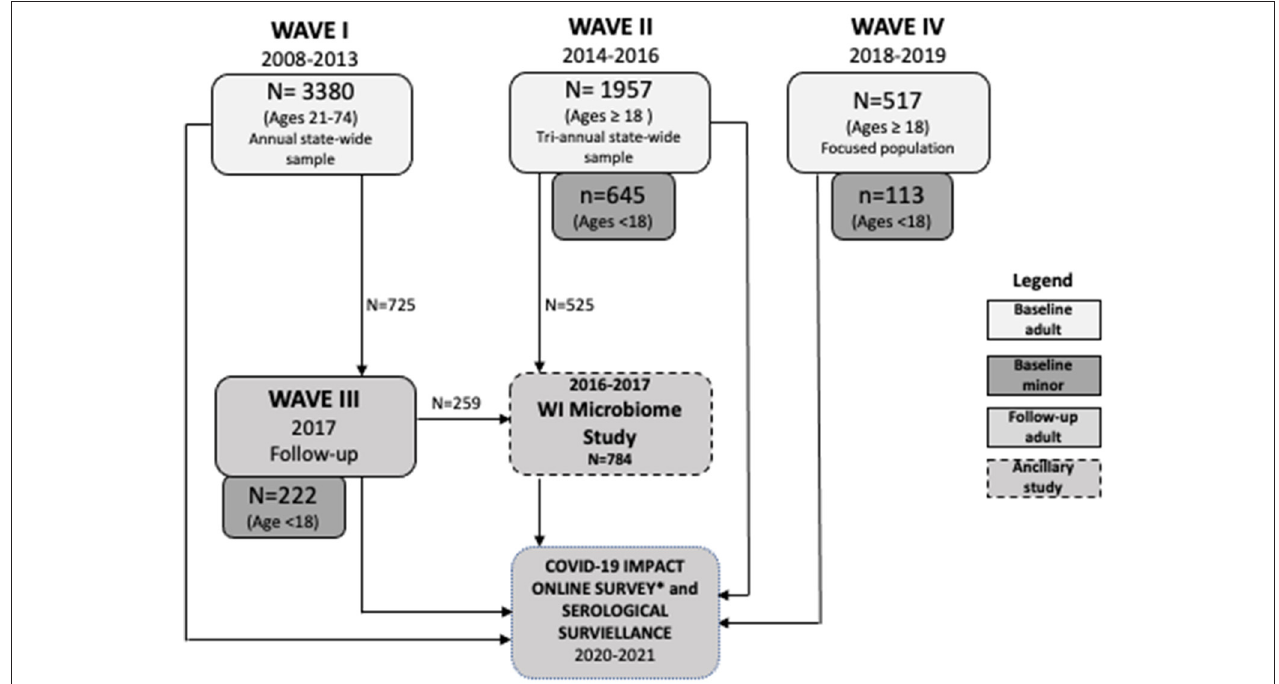
FIGURE 1 | Survey waves and follow-up participation.